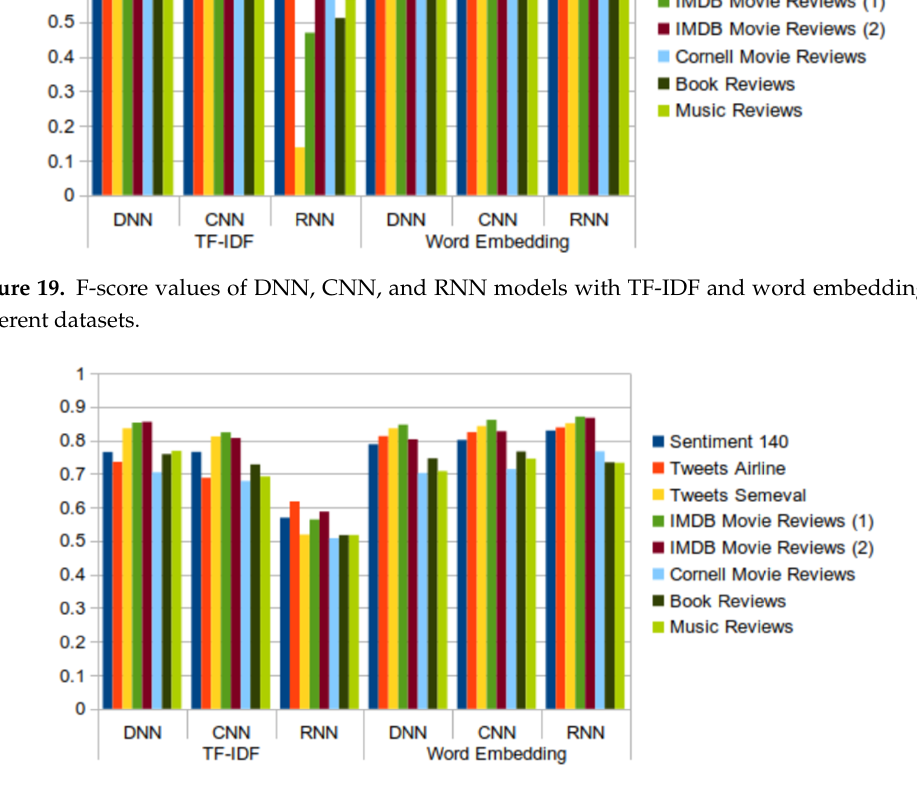
Table 7. CPU times of experiments with numbers of tweets with a GPU.